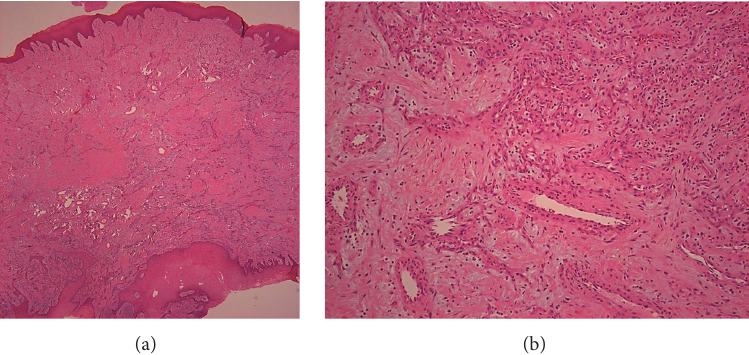
Figure 4: Hematoxylin and eosin (H&E) stain on low power ( × 20, (a)) magnification reveals numerous vascular channels in a background of fibrous connective tissue. A mixed inflammatory cell infiltrate is scattered throughout the stroma. Surface epithelium is present. On high power ( × 100, (b)) magnification, thin walled blood vessels are revealed, lined by endothelial cells. The stroma contains fibroblasts and inflammatory